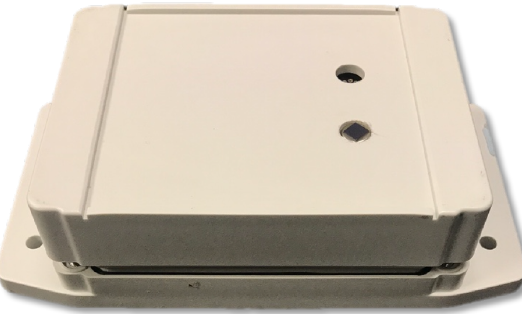
Figure 2. Prototype radiometer with a Dexter ST-60 two-band thermopile. These prototype radiometers are approximately 16 cm × 9 cm × 4 cm in size, and weigh roughly 0.2